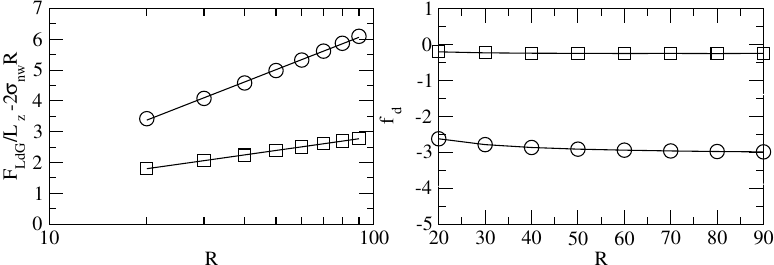
Figure A1. ( Left ) Plot of F LdG / L z − 2 σ sn R as a function of R for w = 0.2. Configurations with opening angle α = π /2 and topological charge + 1 are depicted by circles and configurations with opening angle α = 3 π /2 and topological charge − 1/3 depicted by squares. ( Right ) Plot of f d as a function of R . The meaning of the symbols is the same as in the left